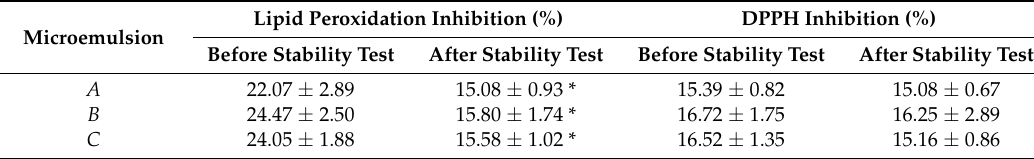
Table 3. Lipid peroxidation and DPPH inhibition of microemulsions before and after the heating-cooling stability